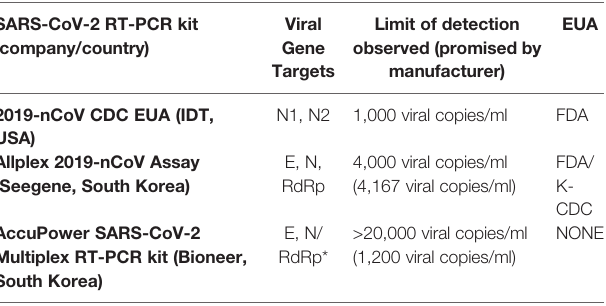
TABLE 2 | Comparison of CDC-RT-PCR protocol, AccuPower SARS-CoV-2 Multiplex RT-PCR and Allplex 2019-nCoV Assay kits. SARS-CoV-2 RT-PCR kit